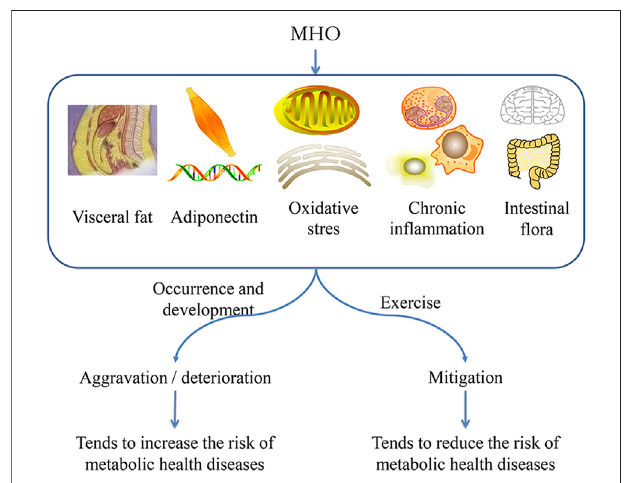
FIGURE 2 | Ways to reduce the health harm of MHO by